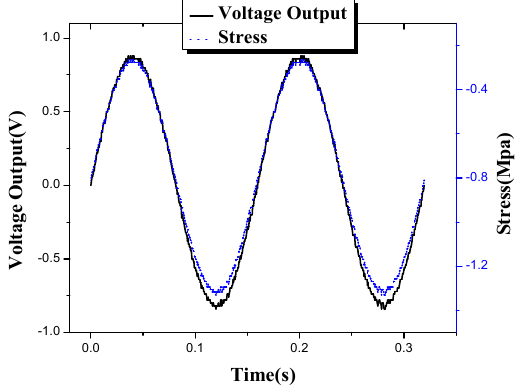
Figure 7. Stress of smart aggregate vs. voltage output at a circle of 0.16 s.